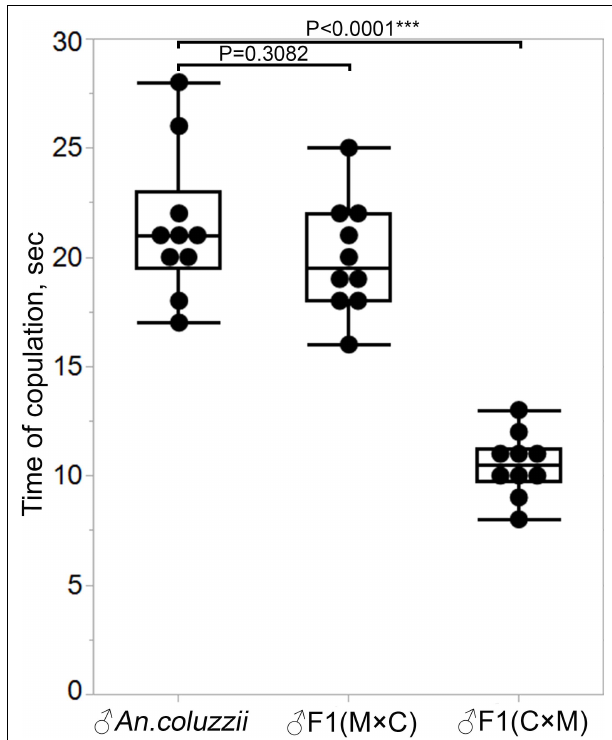
FIGURE 8 | Copulation time between An. coluzzii females and males of An. coluzzii or F1 hybrids. M × C, An. merus × ♀